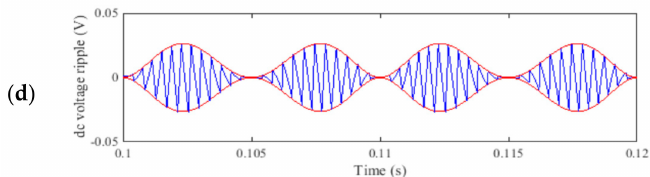
Figure 8. DC-link voltage switching ripple: simulation results (blue trace) and theoretical peak-to-peak envelope (red trace) over a fundamental period for ϕ = 0 ◦ , ( a ) m = 0.25; ( b ) m = 0.5; ( c ) m = 0.75; and ( d ) m = 1.